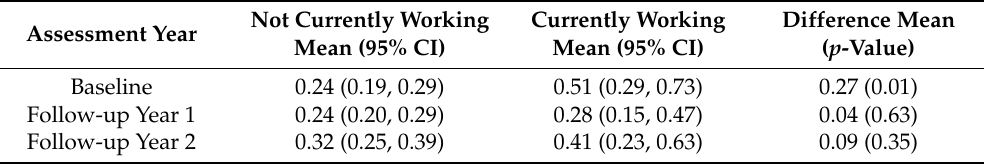
Table 3. Adjusted a mean probability of high or high normal blood pressure at each time point among students who were not working and who were currently